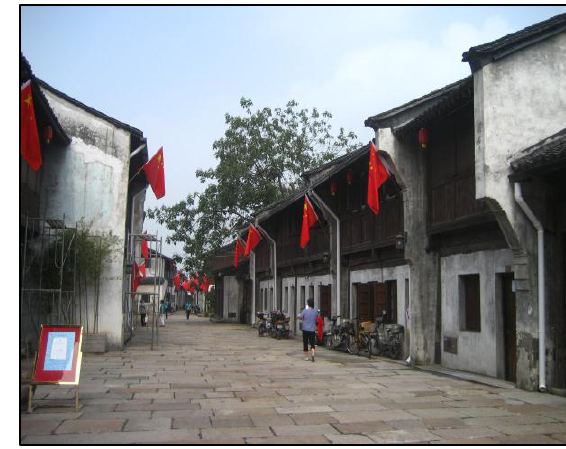
Figure 2 Dwellings at the square of